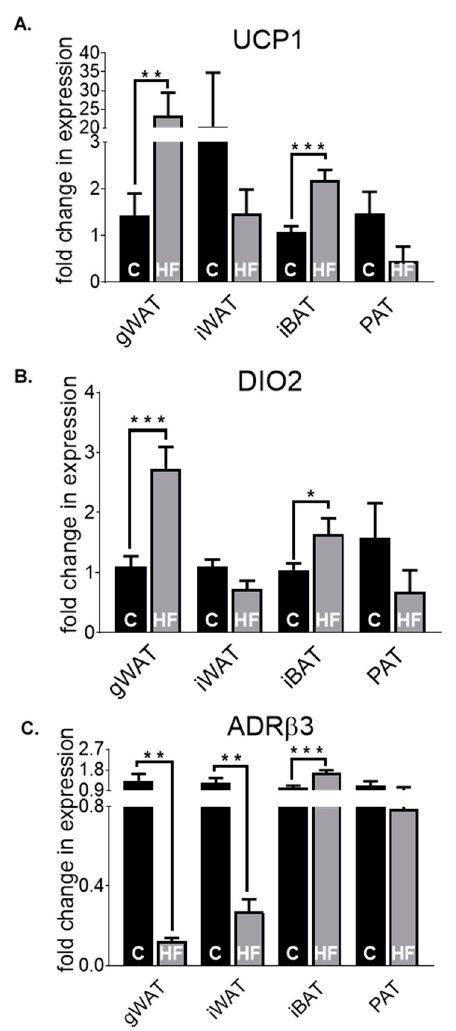
Figure 5. UCP1 ( A ), ADR β 3 ( B ) and DIO2 ( C ) fold change in mRNA expression in gWAT, iWAT, iBAT and PAT of chow (C)- or high-fat (HF)-fed 30-week-old male mice. All data are relative to the housekeeping gene PPIA and normalised to their respective control (C) within each depot. All data represent mean + s.e.m. Data were analysed by an unpaired t -test between C and HF of each depot. N = 6–12. * p < 0.05, ** p < 0.01, *** p < 0.001 and **** p < 0.0001.